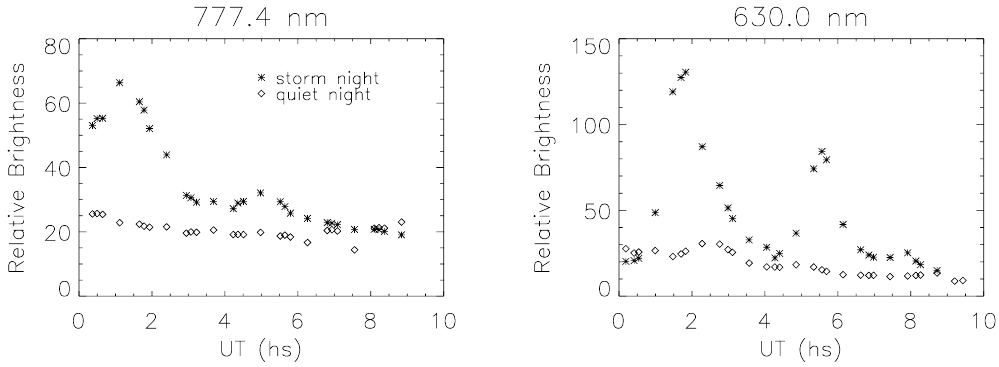
Fig. 9. Average brightness for 777.4nm emission (left) and 630.0 nm (right). Stars indicate data points during the storm night; diamonds represent data for a “control night” (see